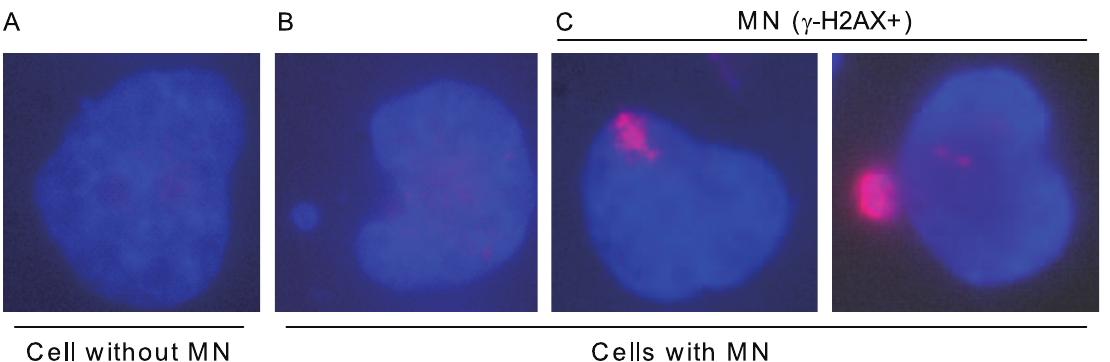
Figure 6. Classification of cells into different categories based on the presence of MN and c -H2AX signal within MN. DAPI stained DNA is shown in blue, and c -H2AX immunofluorescence signal is shown in red. The different groups: A, Cells without MN, B, Cells with MN, and C, Cells with MN ( c -H2AX + ) are indicated.